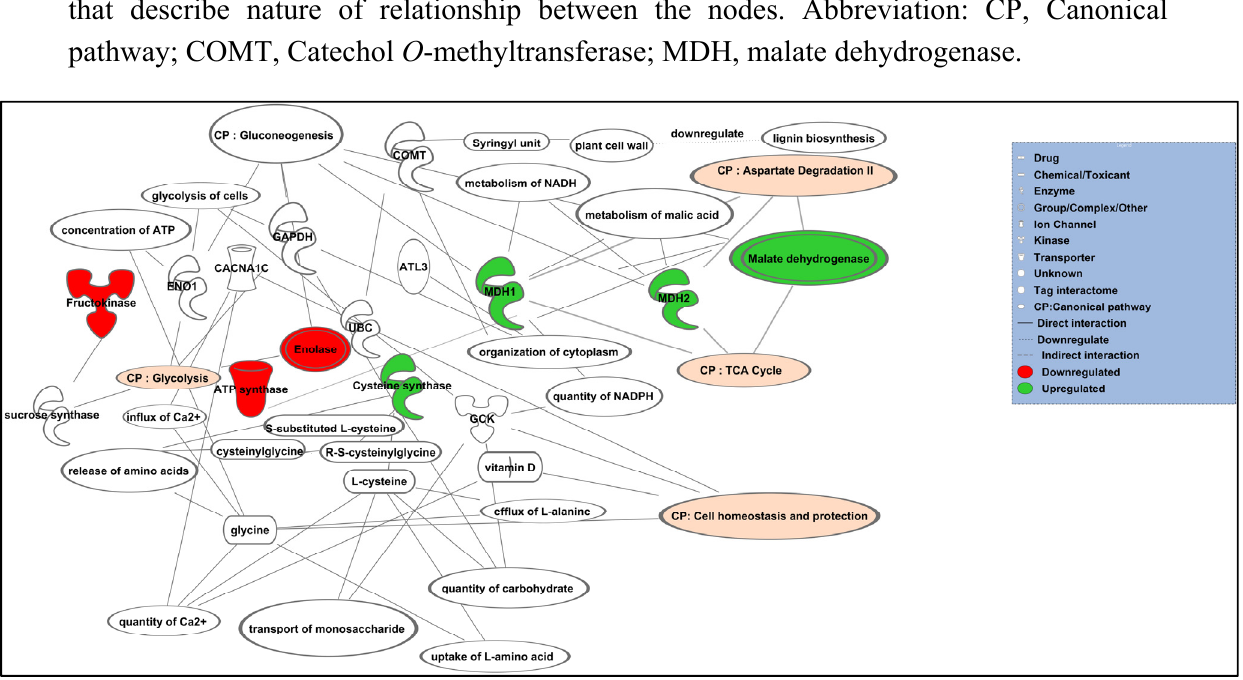
Figure 4. Predicted canonical pathway of altered abundance root proteins of oil palm following infection of G. boninense . Lines between proteins represent known interactions. Nodes in red indicate up-regulated proteins while those in green represent down-regulated proteins. Various shapes of nodes represent functional class of proteins. Different arrow shapes represent different types of interactions. Edges are displayed with various labels that describe nature of relationship between the nodes. Abbreviation: CP,